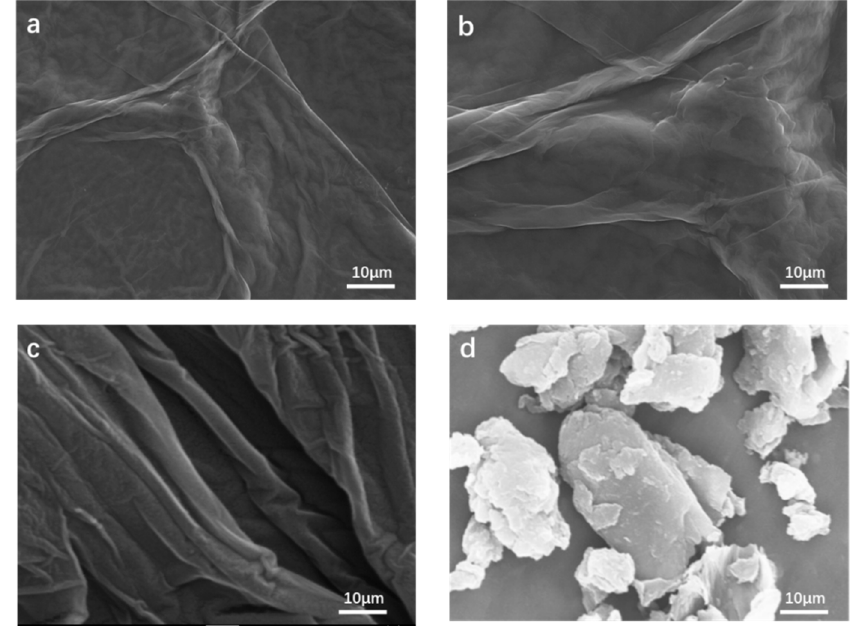
Figure 3. ( a , b ) SEM image of graphene oxide; ( c ) SEM image of E-RGO; ( d ) SEM image of E-RGO/APAM.